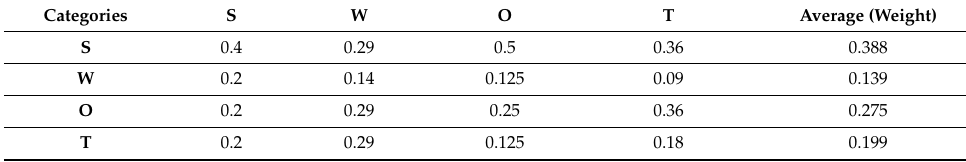
Table 9. Normalized matrix for calculating weight.